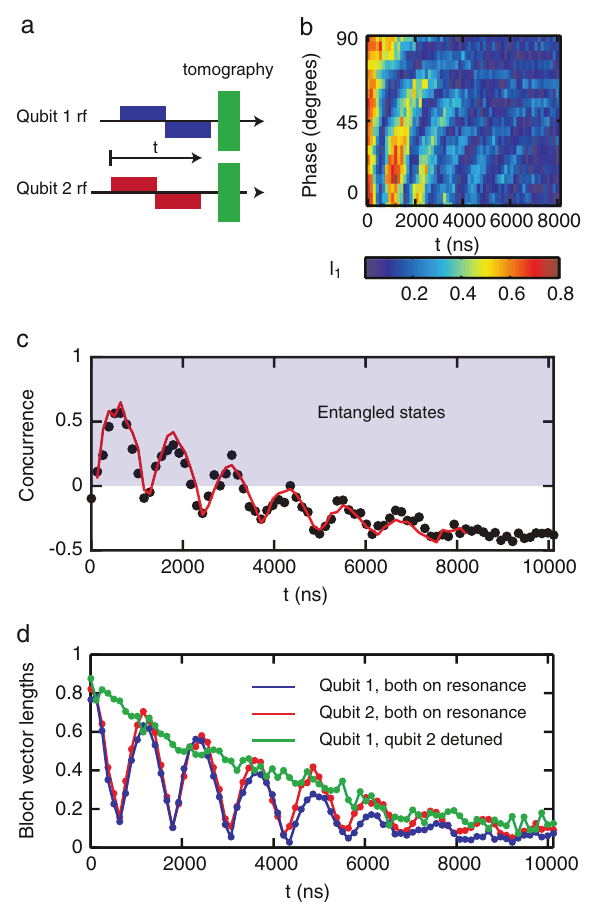
Fig. 3 Entangling gate. a To entangle the qubits, we perform a simultaneous rotary echo on both for a varying total length of time t , followed by tomographic readout to reconstruct the two-qubit density matrix. b Bloch vector length for qubit 1, l 1 , during the entangling gate as the phase between rf drives varies. Nodes in l 1 denote entanglement. The entanglement rate vanishes when the qubits are driven 90° out of phase. c Concurrence vs. time for the entangling gate. Positive values of concurrence indicate entangled states. Negative values of concurrence indicate decoherence. The solid red line is a theoretical simulation taking into account hyper fi ne and low- and high-frequency charge noise (see Supple- mentary Information). d Single-qubit Bloch vector lengths l 1 and l 2 during joint evolution. When the qubits are detuned from each other, the interaction